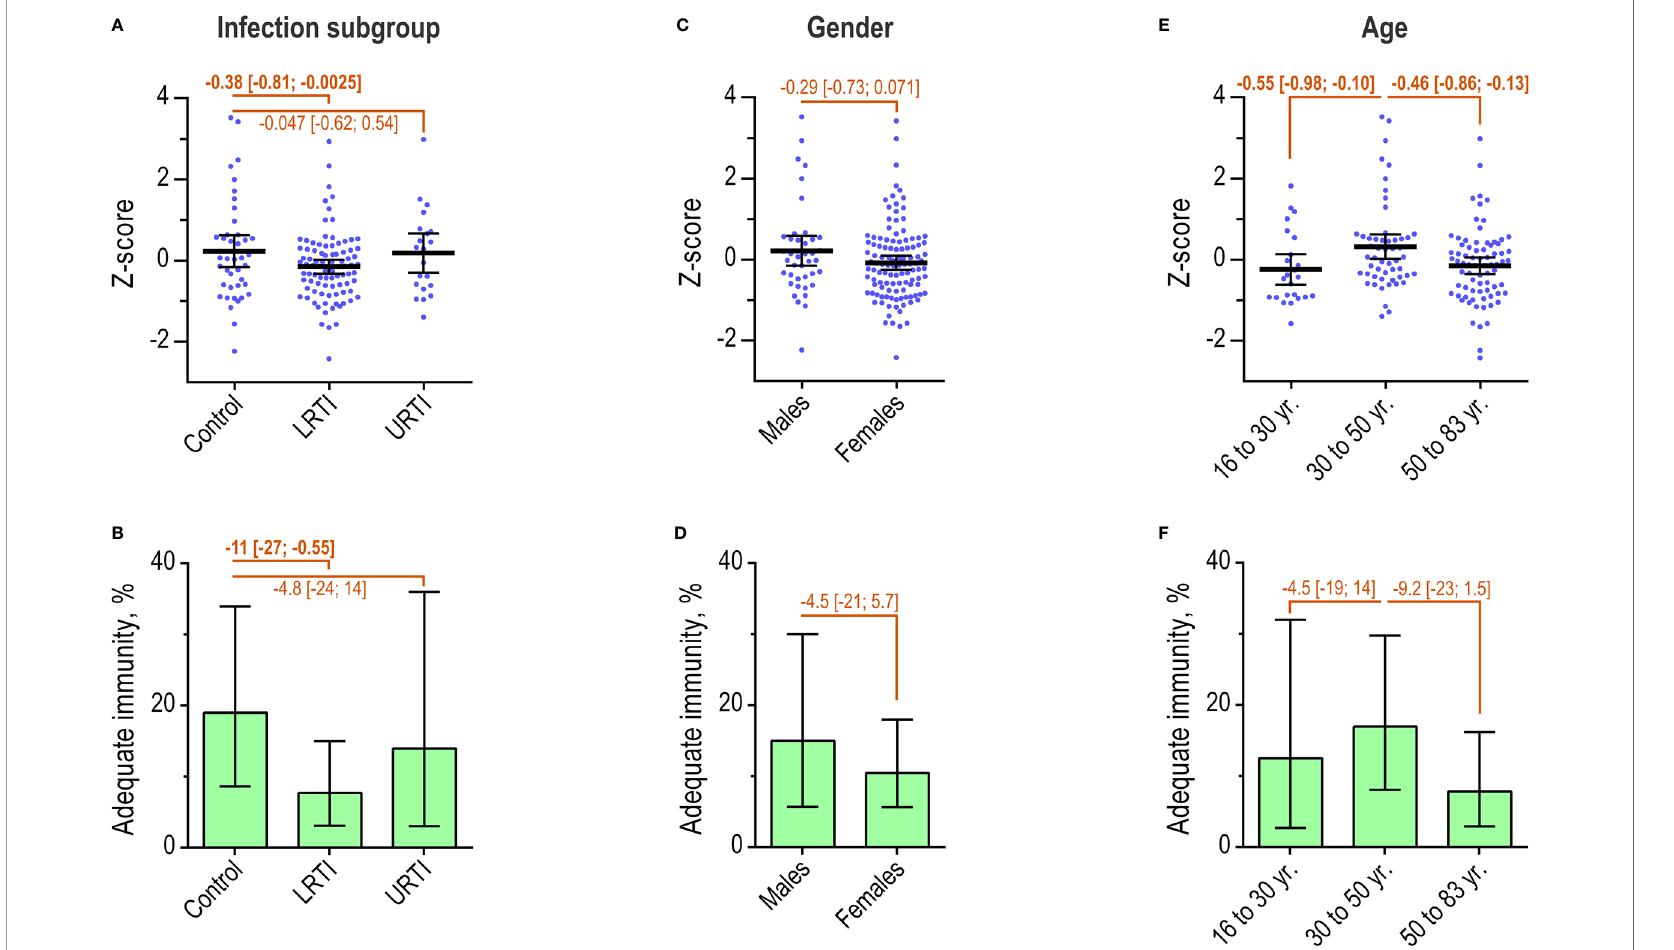
FIGURE 6 | Natural immunity in patient subgroups. (A) Individual Z-scores and mean with 95% con fi dence interval for patients ( n = 154), by infection pro fi les. Differences between groups were determined as indicated. (B) The percentage of patients with ‘ adequate ’ immunity according to the AAAAI guidelines, by infection pro fi les. Error bars are 95% con fi dence intervals. (C) As in A, but for patients by gender. (D) As in B, but for patients by gender. (E) Individual Z-scores for patients by age intervals. (F) As in B, but for patients by age